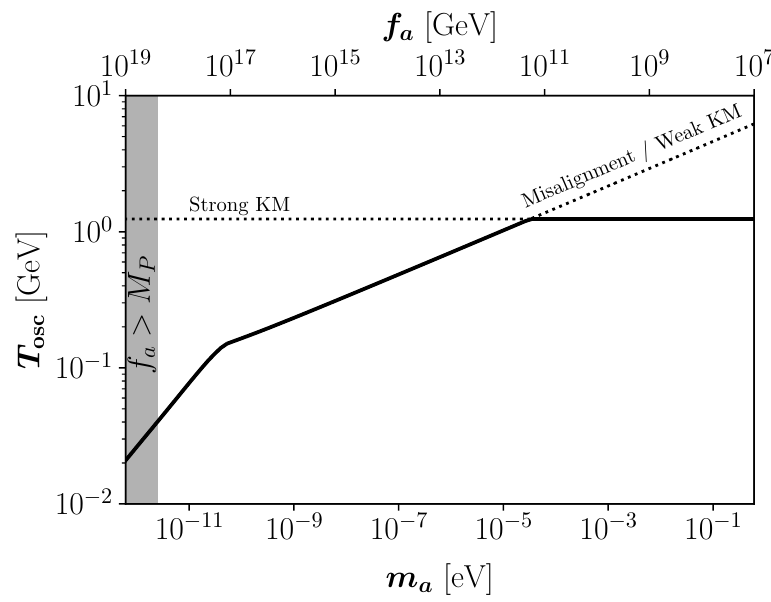
Figure 5. The temperature of the primordial plasma at the onset of axion field oscillations T osc as a function of the axion mass. The tilted dotted line corresponds to the cases of standard misalignment or weak KM regimes in Equation (13), while the horizontal dotted line is the result in the strong KM regime in Equation (26). Table 1. Conditions for the various scenarios of misalignment mechanism discussed in the text. Mechanism Initial Velocity Oscillation Temperature Standard